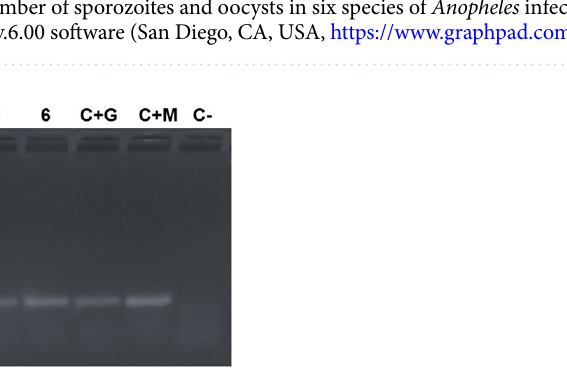
Figure 5. Polymerase chain reaction for detection of P. vivax in the saliva of six species of Anopheles. (L) DNA Ladder; ( 1 ) An . triannulatus ; ( 2 ) An . nuneztovari ; ( 3 ) An . benarrochi ; ( 4 ) An . evansae ; ( 5 ) An . darlingi ; ( 6 ) An . aquasalis ; ( C + G ) Positive control (salivary gland + P. vivax ); ( C + M ) Positive control (midgut + P. vivax ); ( C- ) Negative control. Original gels are presented in Supplementary Fig.